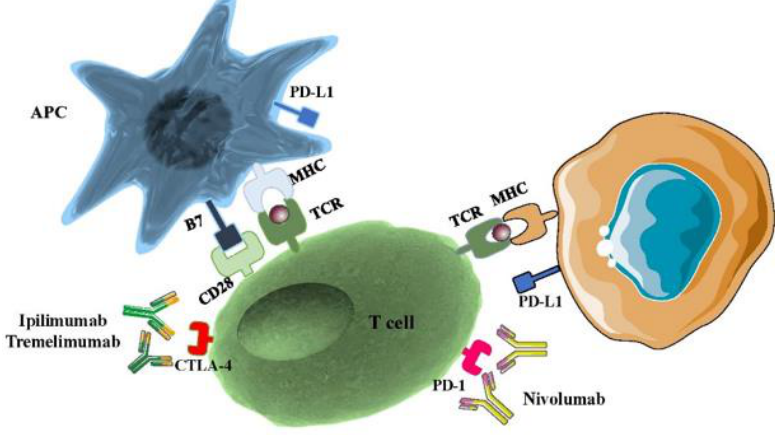
Figure 2. Mechanism of CTLA-4 and PD-1 inhibition.